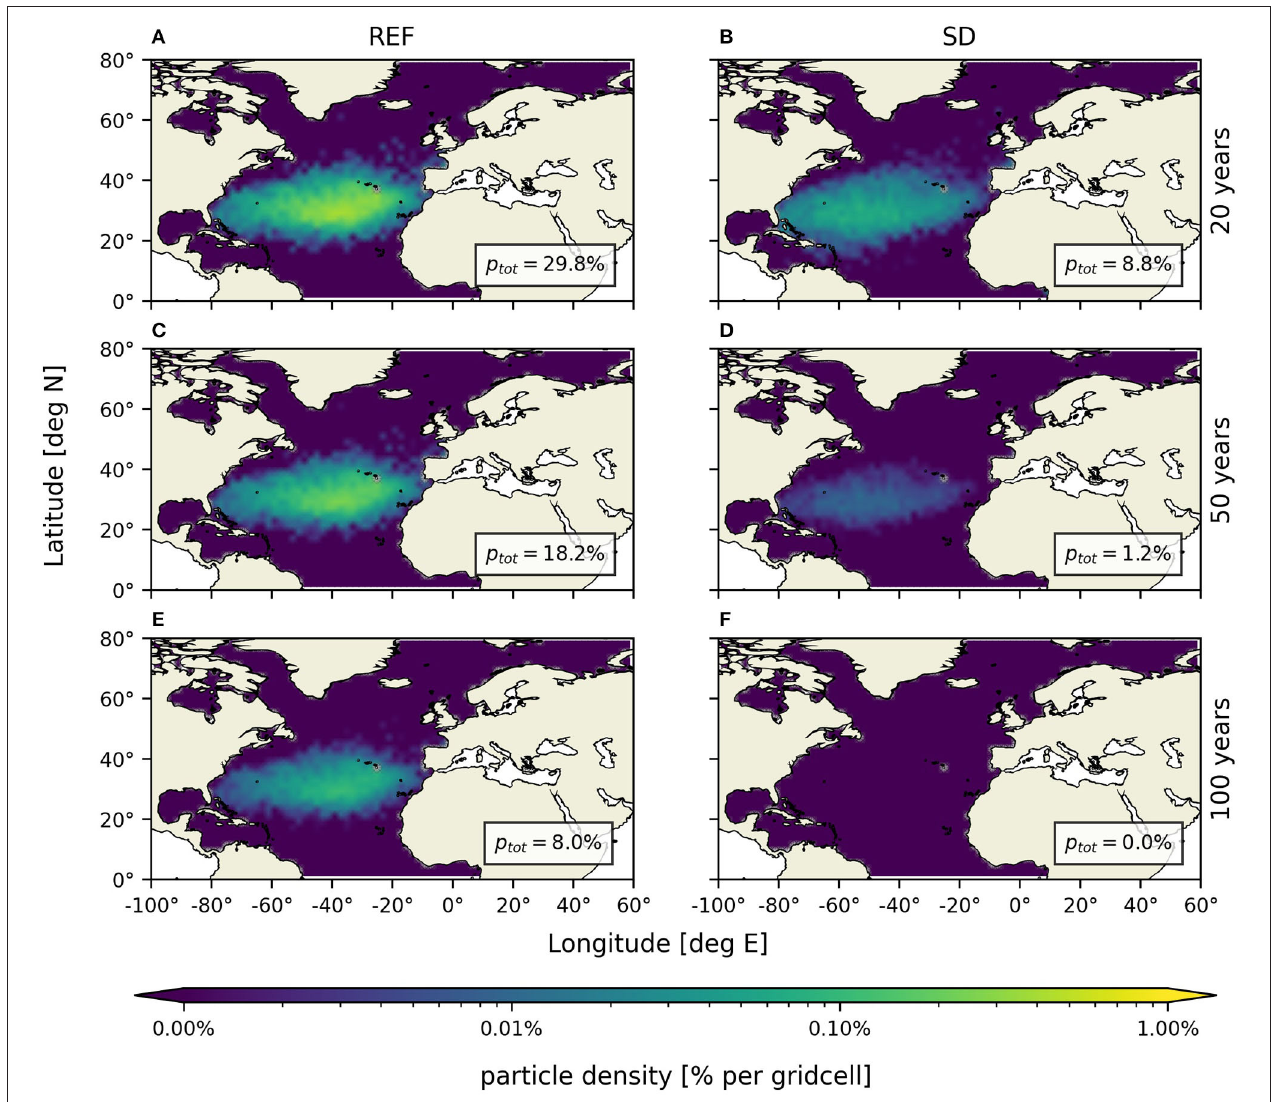
FIGURE 7 | Adjacency matrix predictions after 20 (A,B) , 50 (C,D) , and 100 years (E,F) . P ij is calculated with 1 t = 10 years to match the timescale of the prediction. Note the logarithmic scale in the colourbar.